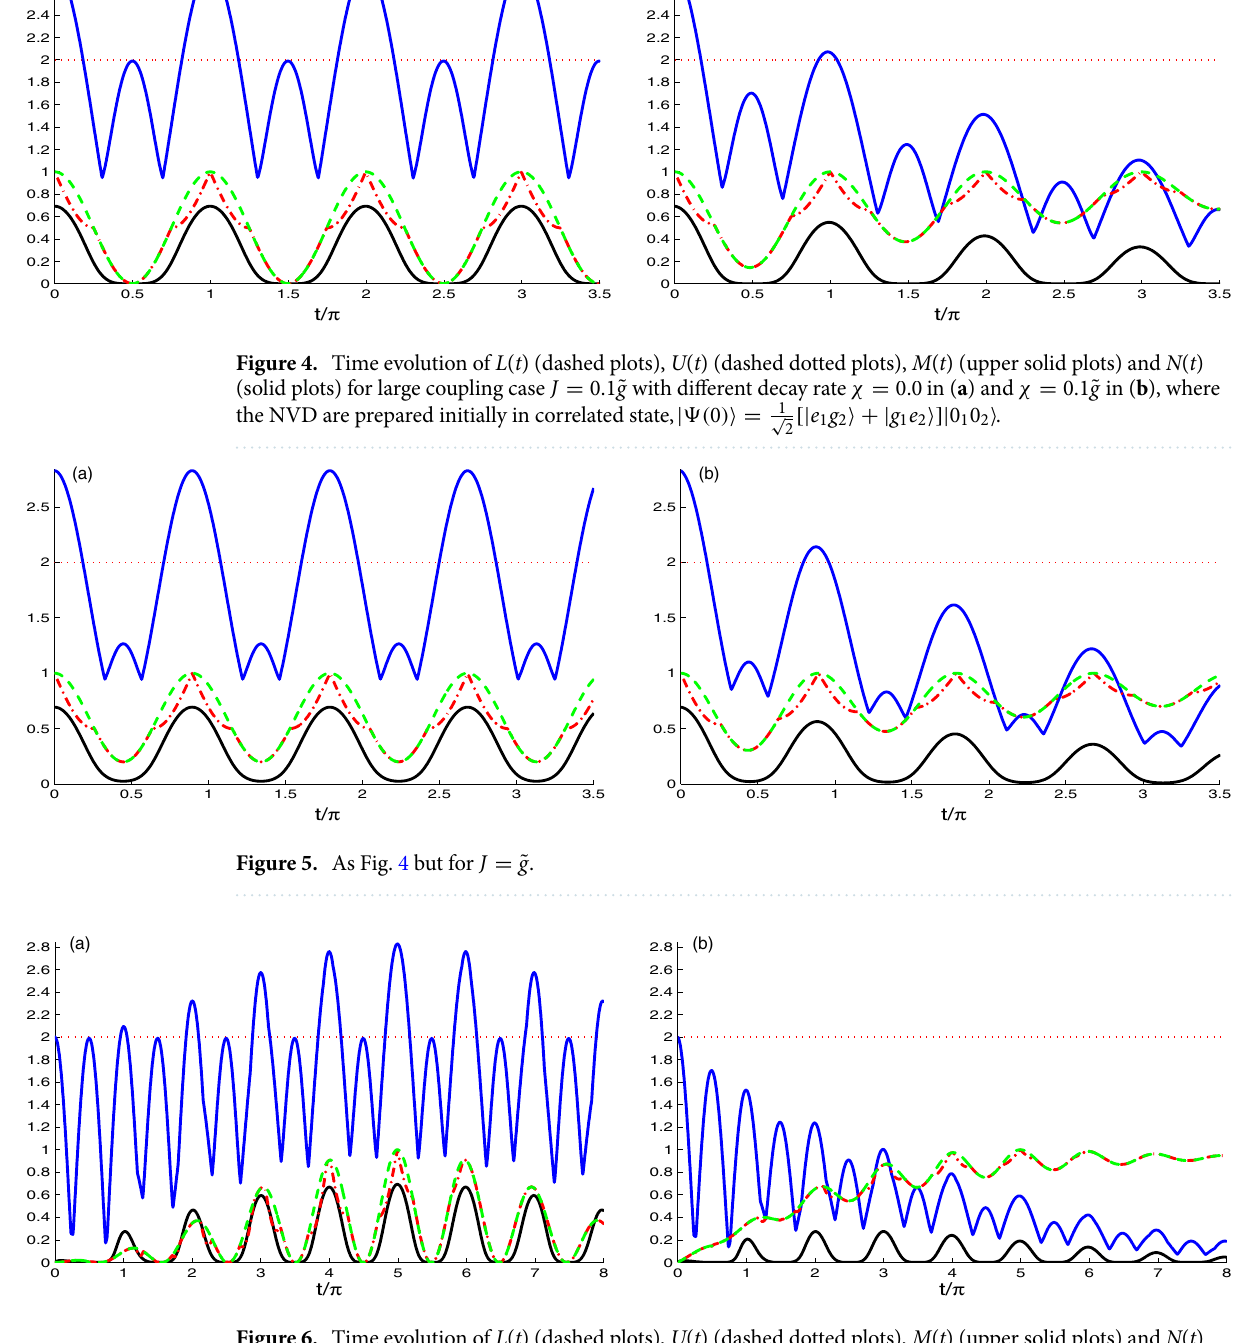
0.1 g with different decay rate χ = ˜